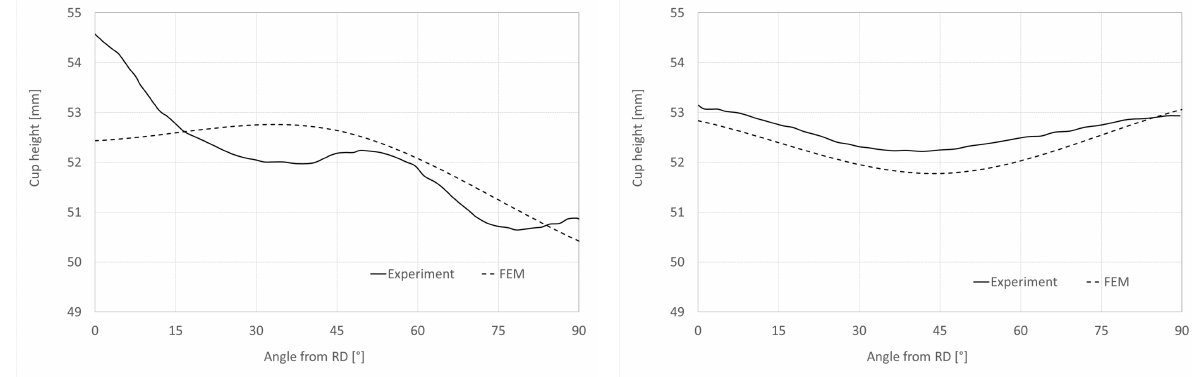
Figure 7: Ear profile of the cup from aluminium alloy AA5352 (left) and steel sheet TH330 (right)